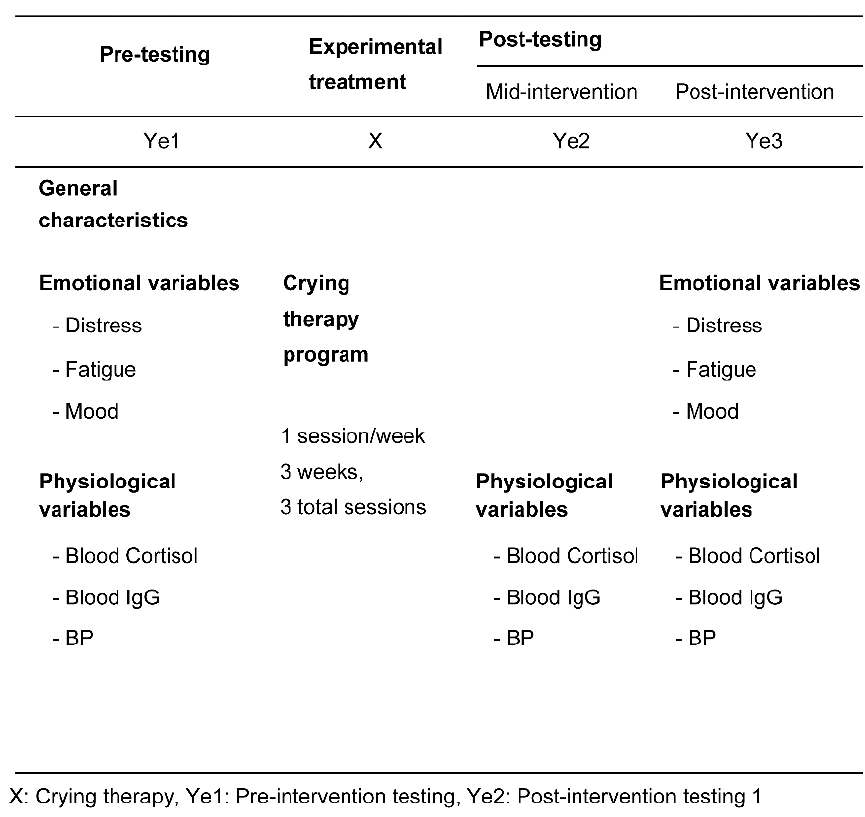
Figure 1. Research design.